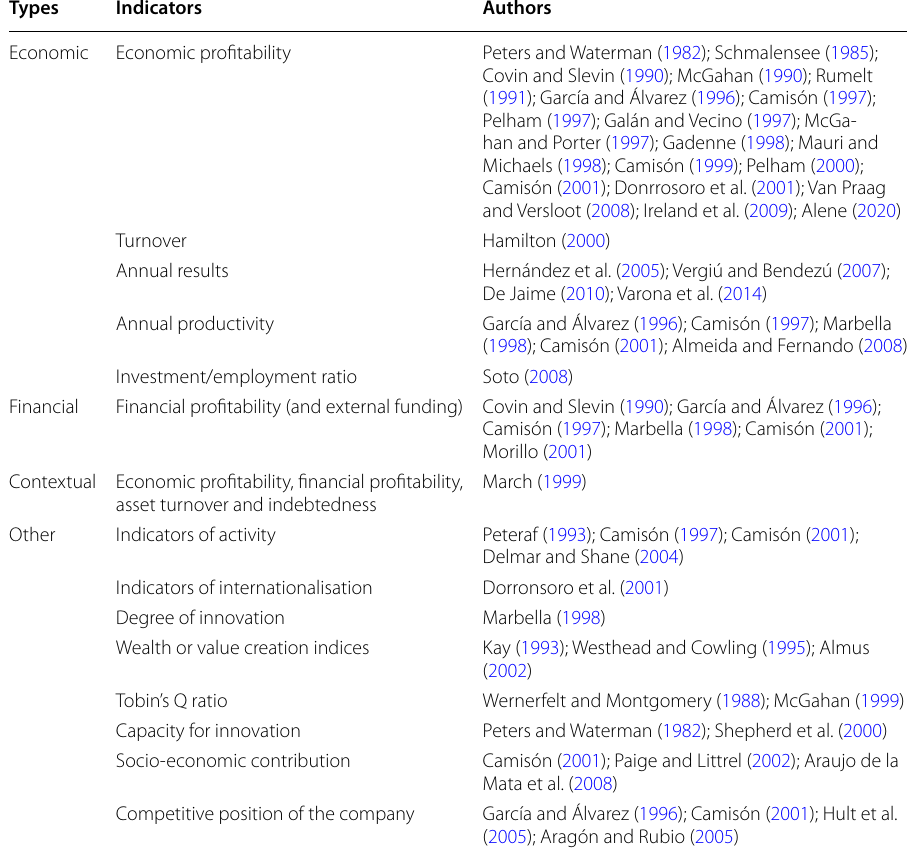
Table 1 Some indicators to measure